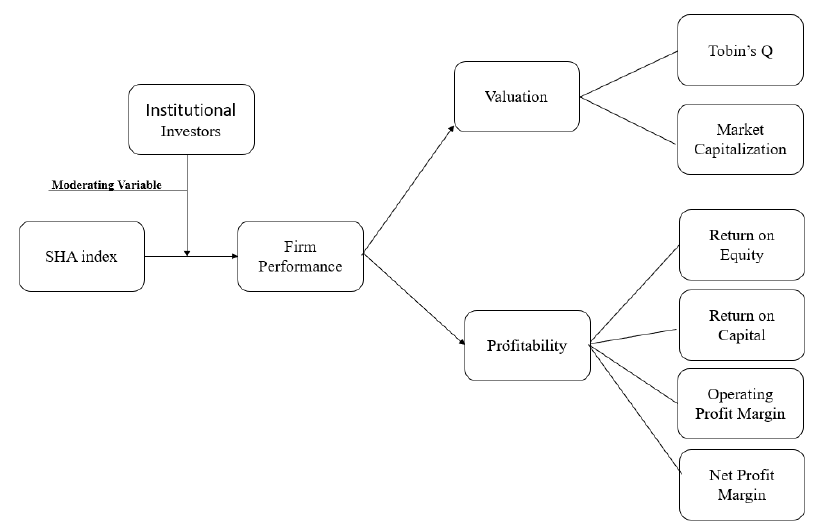
Figure 1. Conceptual model of the study. Source: Authors Compilation. Note: Conceptual model presented in Figure 1 explains the plan of the study in detail.